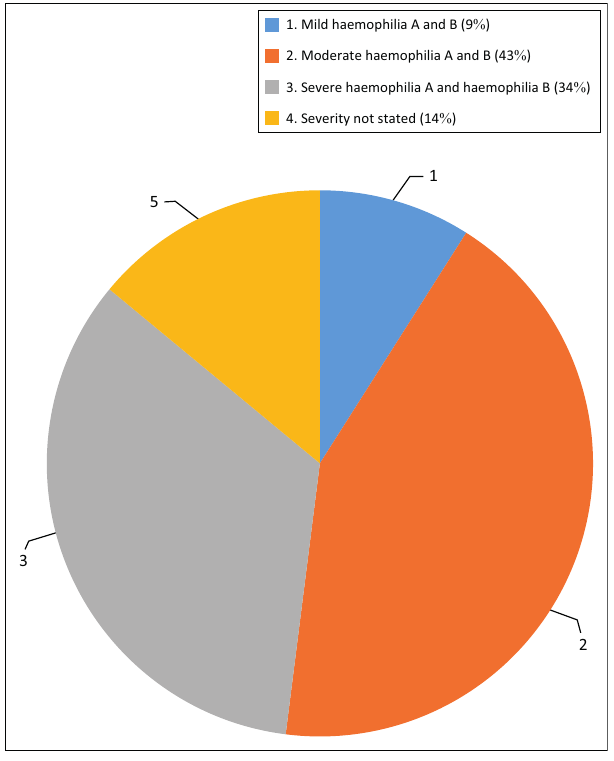
FIGURE 1: Distribution of disease severity amongst all patients with congenital haemophilia.